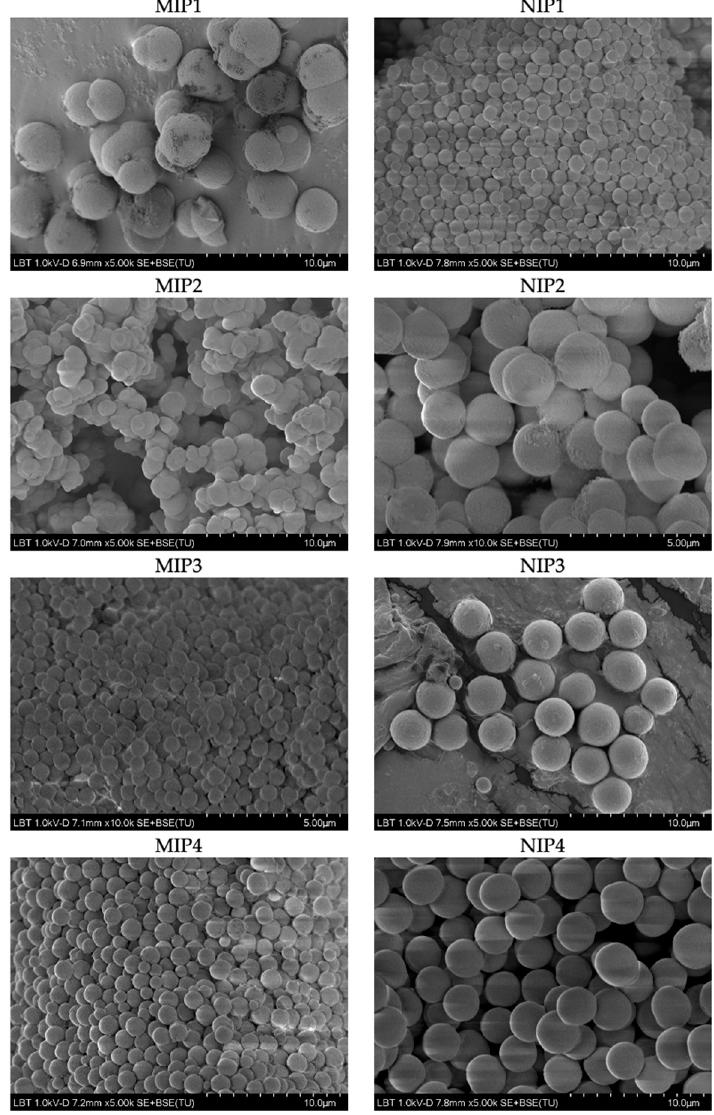
Figure 5. SEM images of studied MIPs and corresponding